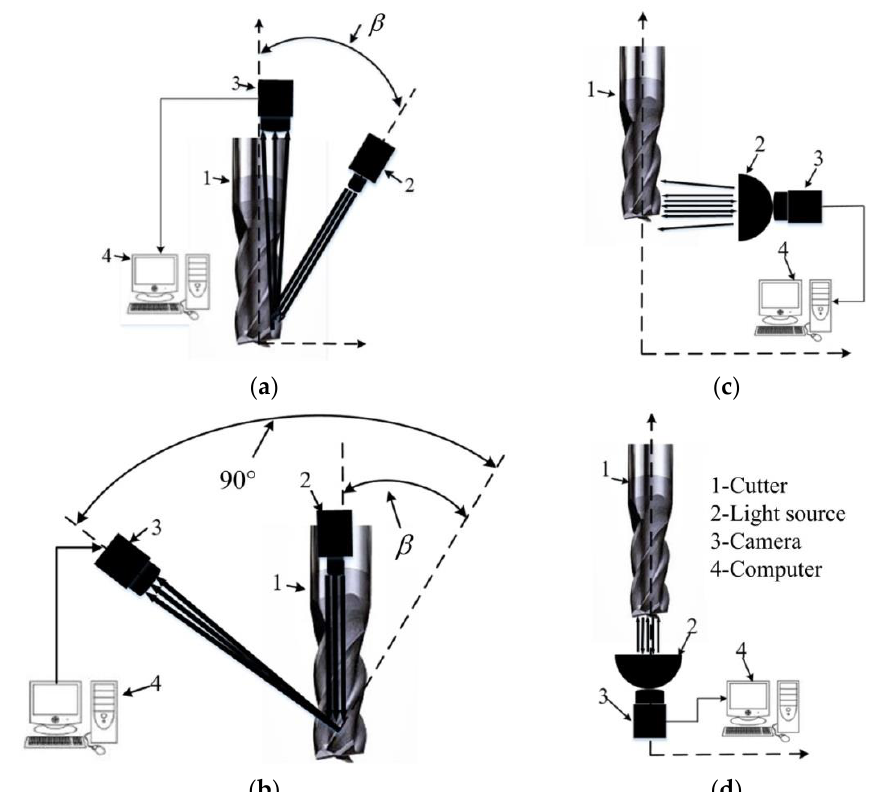
Figure 2. Schematic diagrams of image acquisition methods for different parts: ( a ) Side view of rake face with point light and cameras; ( b ) Back view of rake face with point light and cameras; ( c ) Flank face with dome light and cameras; ( d ) Tool tip with dome light and cameras. β is the helix angle of the cutter.